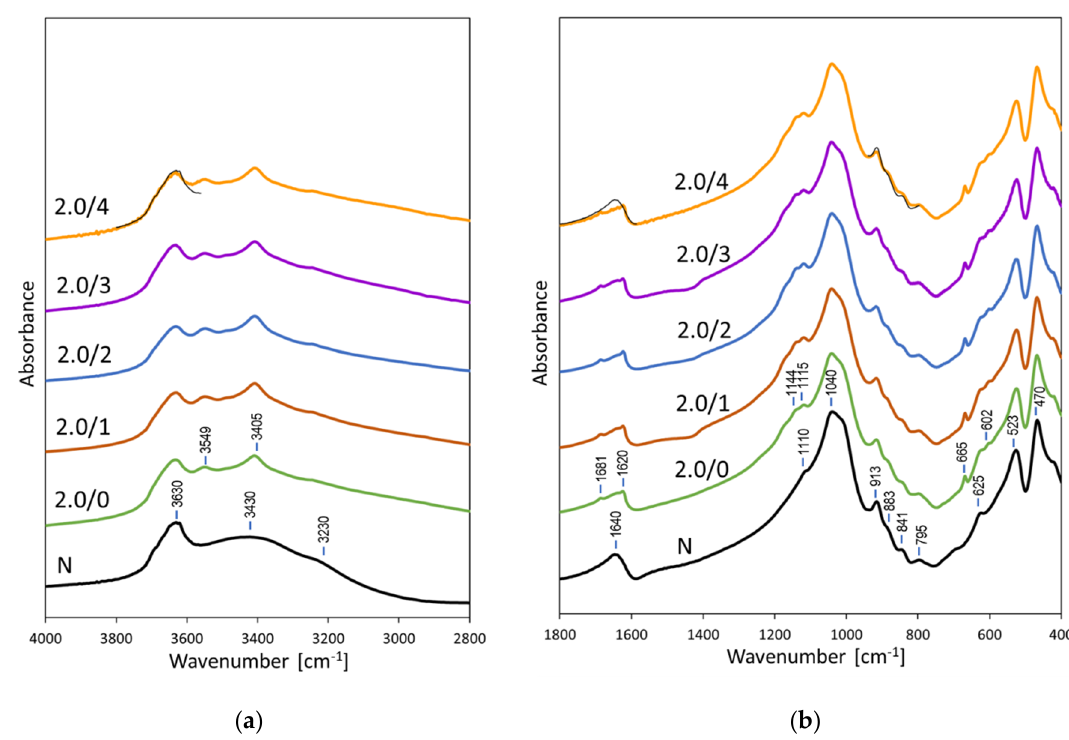
Figure 2. Evolution with the time of aging of FTIR patterns of bentonite impregnated with H 2 SO 4 in quantity corresponding to 2.0 × CEC of clay: ( a ) 2800–4000 cm − 1 range; ( b ) 400–1800 cm − 1 range. To facilitate comparison the relevant fragments of spectrum of non-treated bentonite are superimposed on the spectrum of 2.0/4 sample (thin black line trace).